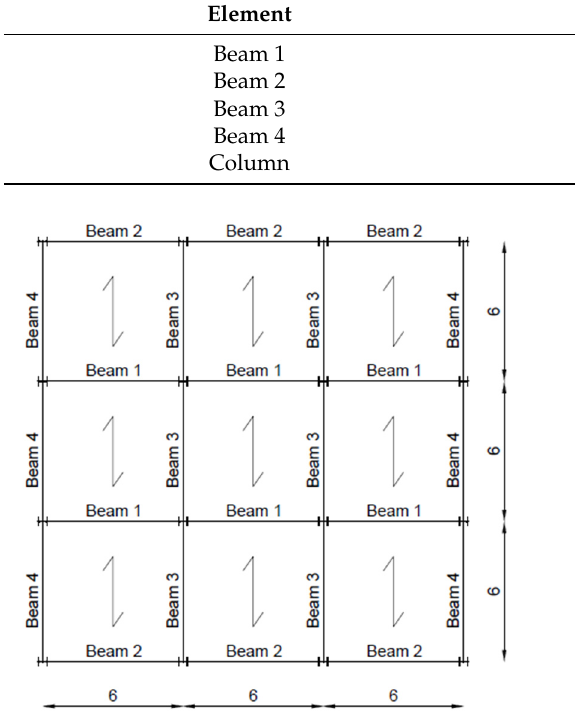
Figure 10. Warping of the floors and the numbering of the beams (valid for all of the case studies).